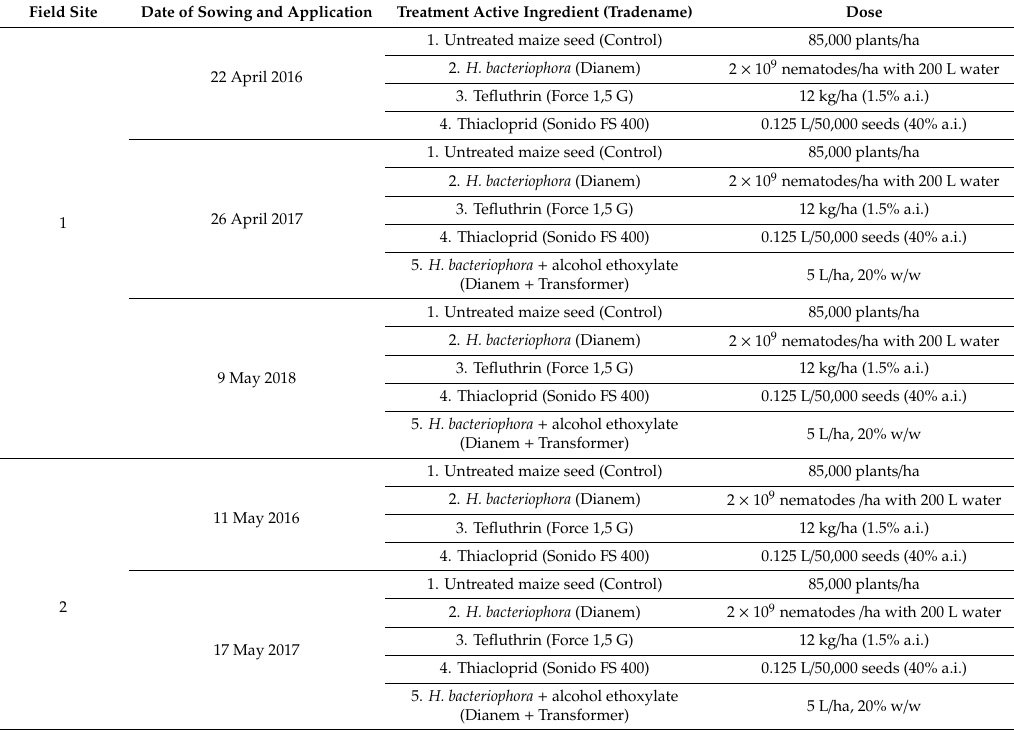
Table 2. Western corn rootworm management on two field sites in three consecutive years (2016–2018). Site 1—Buˇceˇcovci E Slovenia; site 2 —Šmartno pri Cerkljah, N